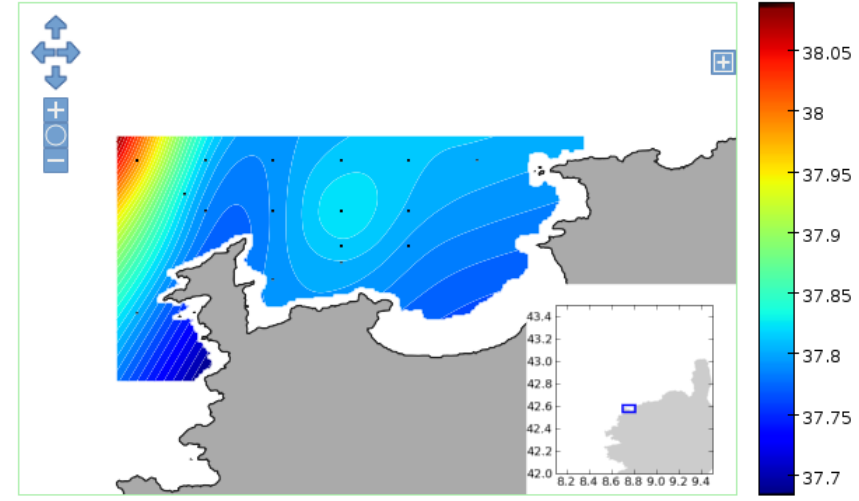
Fig. 7. Climatological spring salinity at 20m in the Bay of Calvi (Corsica, France) using a specialized high-resolution bathymetry of the North West Corsica from the RACE project.